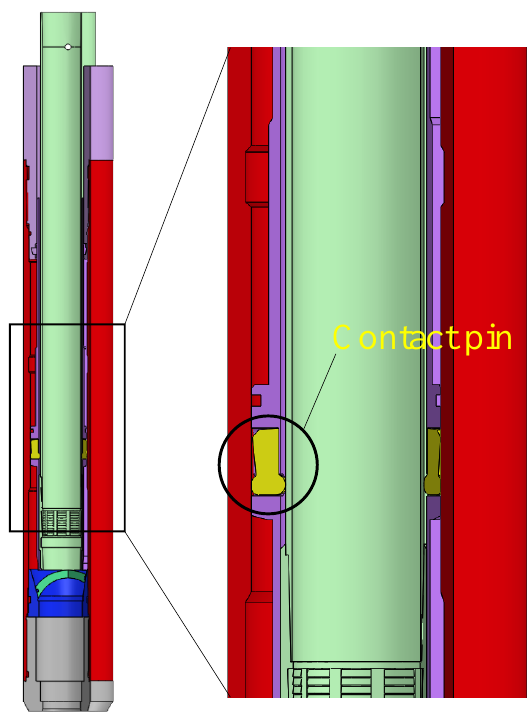
Figure 5. Geometric design of contact pin and force state during action.